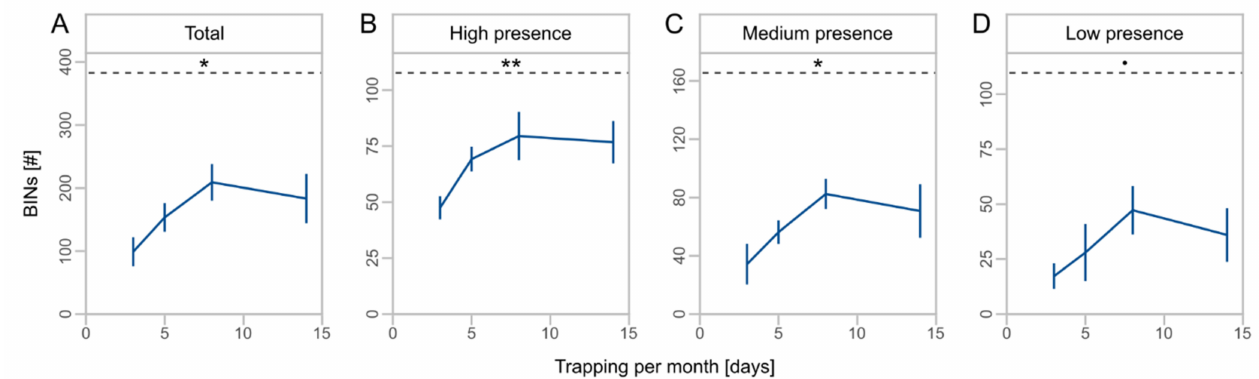
Figure 3. Mean number of barcode index numbers (BINs) ± SD for different days of monthly trapping for total BINs ( A ) and subsets ( B – D ) with high (taxa caught at 4 sites), medium (taxa caught at 2 or 3 sites), and low presence (taxa caught at 1 site). Asterisks indicate significant effects of monthly trapping duration on number of BINs (significance codes: ** p < 0.01, * p < 0.05, • p < 0.1). Dashed lines indicate the mean total number of BINs. Note different scale of y-axes.